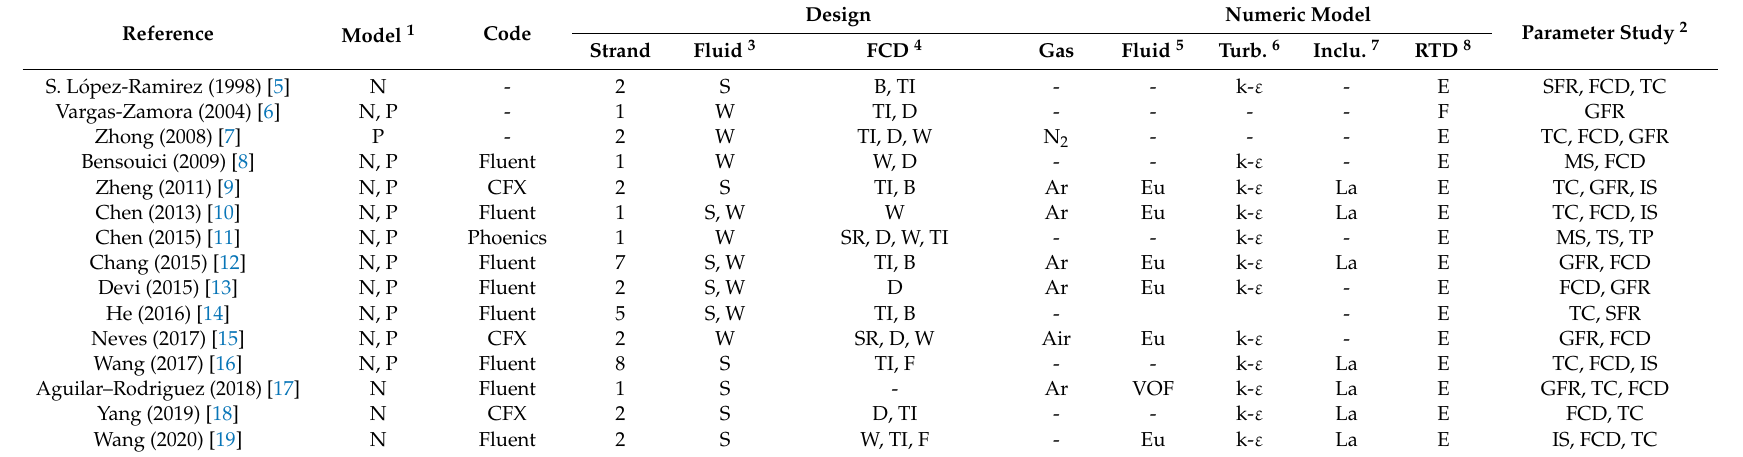
Table 1. Summary of mathematical modeling investigations on residence-time distribution (RTD) in the